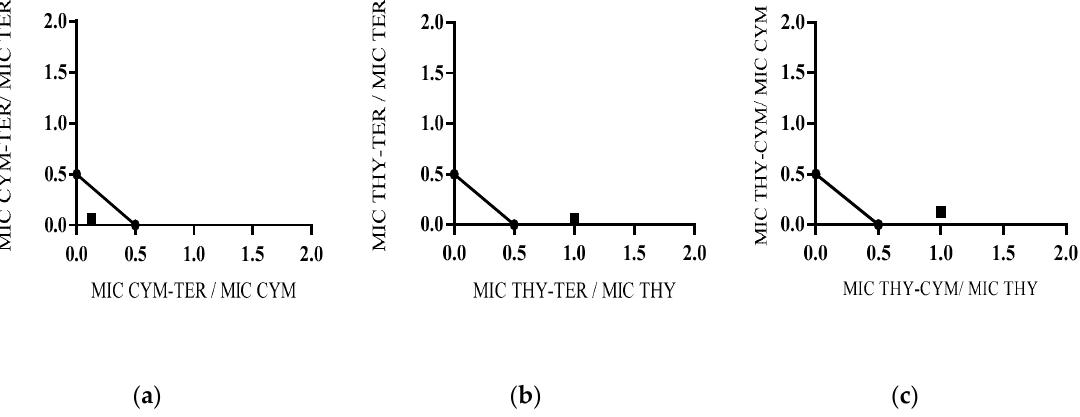
Figure 3. ( a ) Isobologram of p-cymene and γ -terpinene in RTO against P. digitatum ITEM 9569; ( b ) isobologram of thymol and γ -terpinene in RTO against P. digitatum ITEM 9569; ( c ) isobologram of thymol and p-cymene in RTO against P. digitatum ITEM 9569.